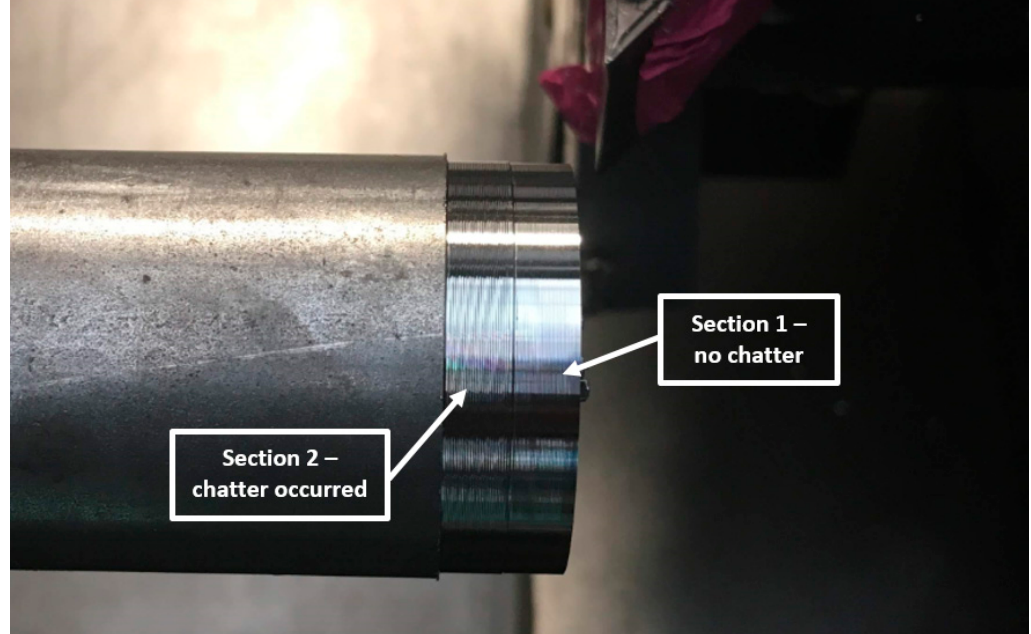
Figure 12. Experimental test “2” results—machined surfaces.